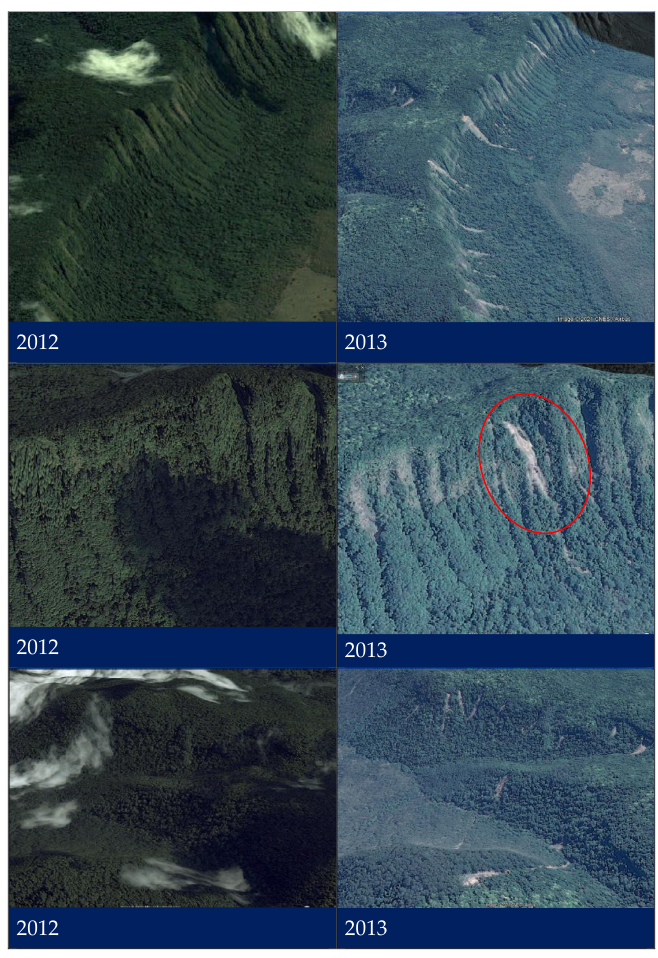
Figure 3. Images assembled from Google Earth, displaying significant historic disturbance events at Main Range National park between 2012–2013. The landslips post the 2012 flooding can be identified as the exposed ground or cleared hill face (for example, see red circle).